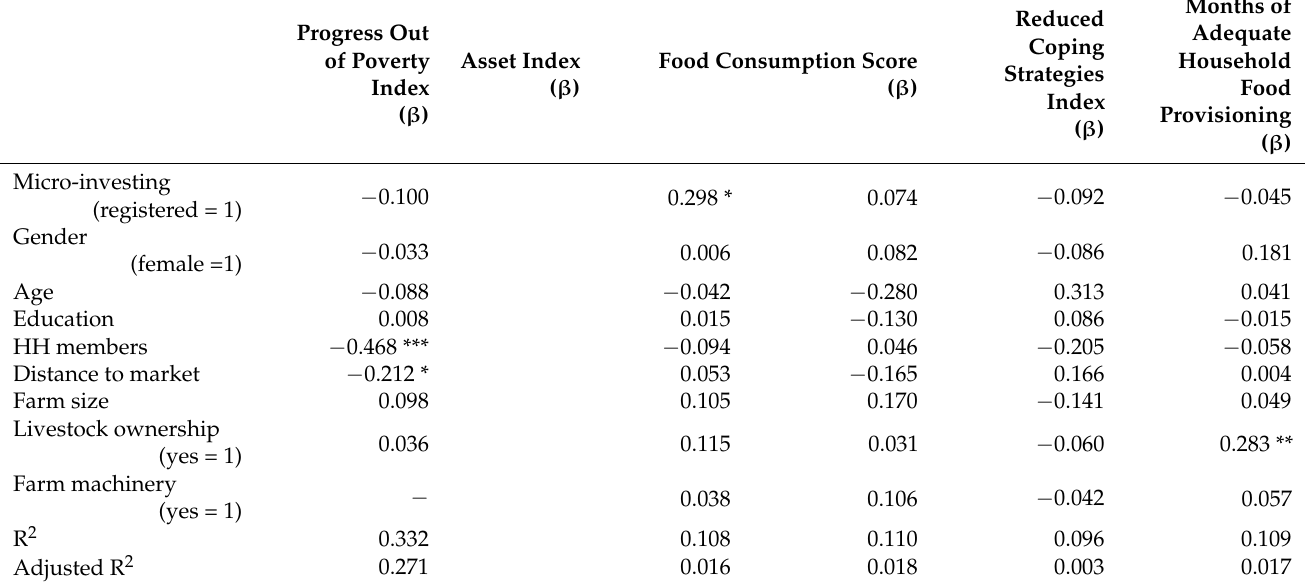
Table A2. Results of estimation of MI program participation as a determinant of poverty in Hai.